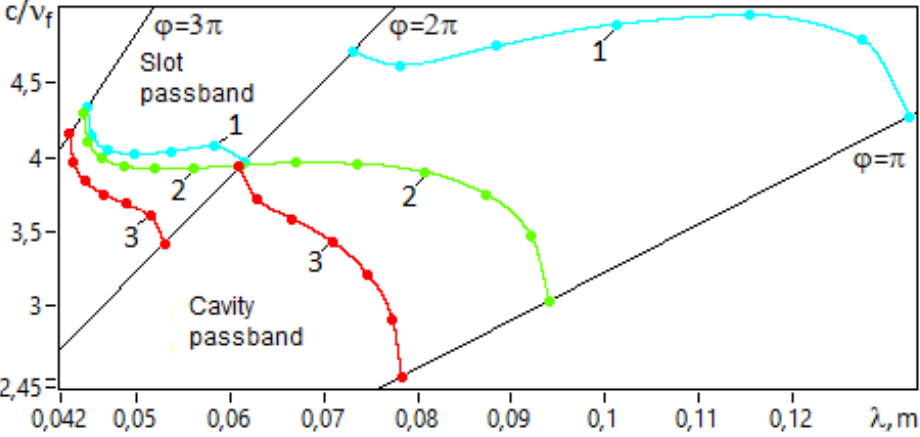
Fig. 2. The dynamics of merge of the cavity and slot passbands SS CCC depending on the angle of the opening of the coupling slot α s with constant period D . 1 – α s = 100 0 , 2 – α s = 132.42 0 , 3 – α s = 190 0 .